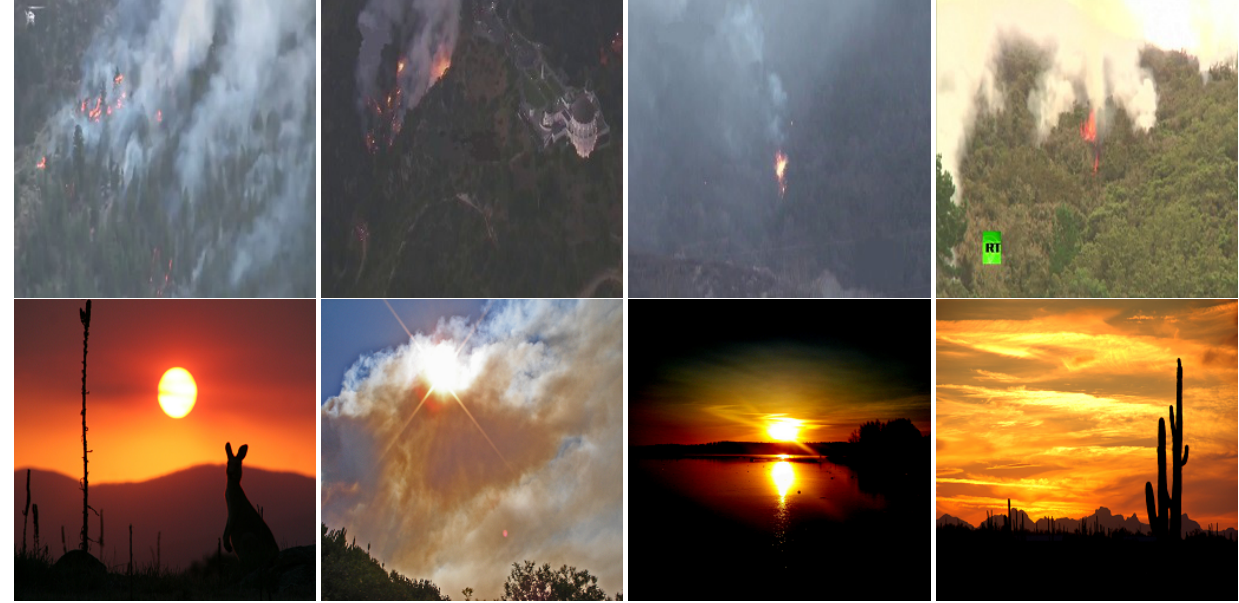
Figure 9. Examples from the FD-dataset. ( Top ): Fire images; ( Bottom ): non-fire